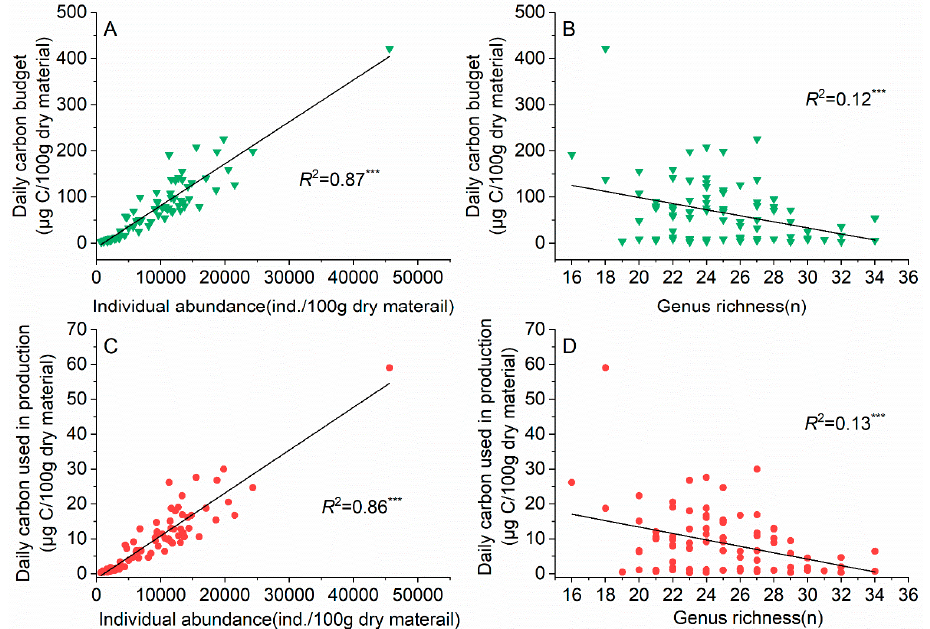
Figure 5. Linear regression analysis of daily carbon used in production and daily carbon budget to individual abundance and genus richness of nematodes in subalpine plantations and natural forests. ( A ): Daily carbon budget to individual abundance. ( B ): Daily carbon budget to genus richness. ( C ): Daily carbon used in production to individual abundance. ( D ): Daily carbon used in production to genus richness. *** p < 0.001.